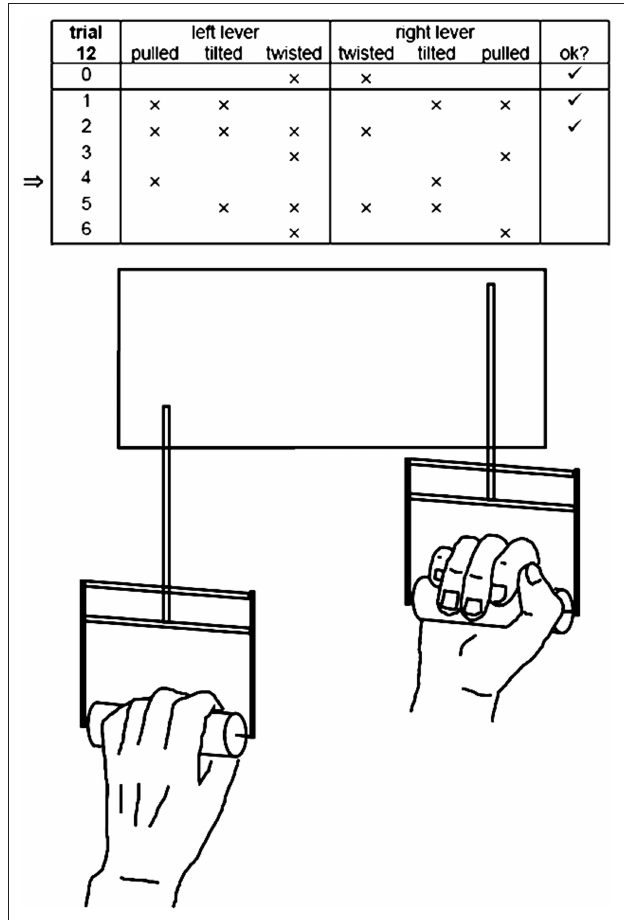
Figure 1 | Lever sequencing: two levers can be independently moved in three dimensions each, i.e., pushed/pulled, tilted and twisted to mechanical stops. After an initial configuration 0, six configurations 1–6 must be positioned as indicated by crosses resp. blanks on the computer